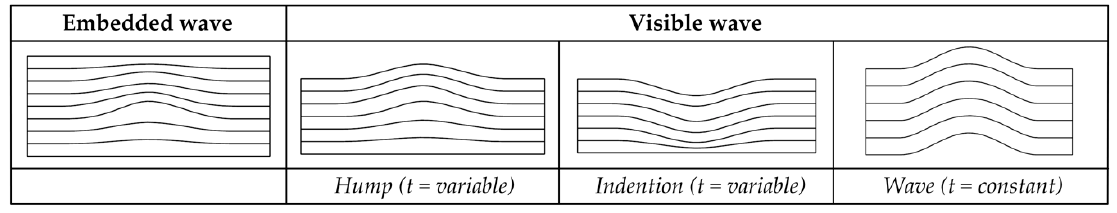
28 of 39 Figure 30. Iso-phase vs. random-phase waviness.